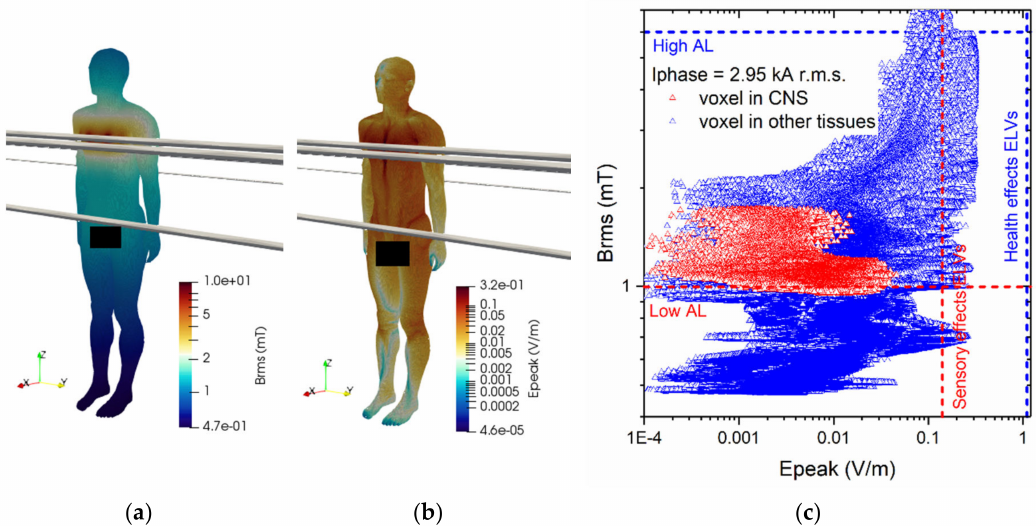
Figure 7. Results for posture A.2. On the left ( a ) the spatial distribution of the B-field amplitude (r.m.s. values in millitesla) over the body surface. In the middle ( b ) the corresponding spatial distribution of the E-field amplitude (peak values in volt per metre) over the body surface. On the right ( c ) the distribution of the voxel